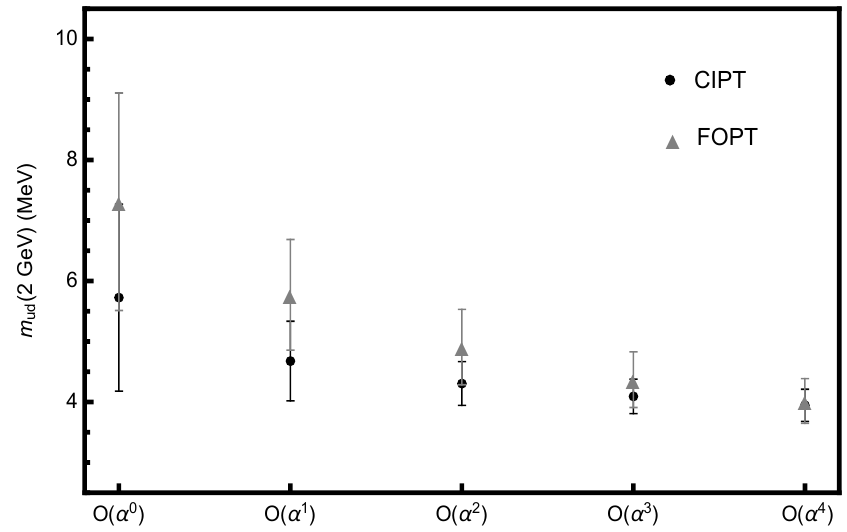
Figure 3 . The quark mass (cid:22) m ud (2 GeV) plotted by successively including higher order terms in the perturbative expansion of the correlator function before integration, in both CIPT and FOPT. dimensional condensates, as their values are poorly known. This constrains substantially the powers of s . Next, the relative contribution of the second resonance should not exceed that of the (cid:12)rst one. The kernel should quench the hadronic resonance contribution at s = s , as well as in the region between the two resonances. The kernel eq. (4.4) also leads 0 to the most stable result for the quark masses in the wide region s Substituting the PQCD result, as given in eqs. (2.1){(2.2), at a typical scale of s